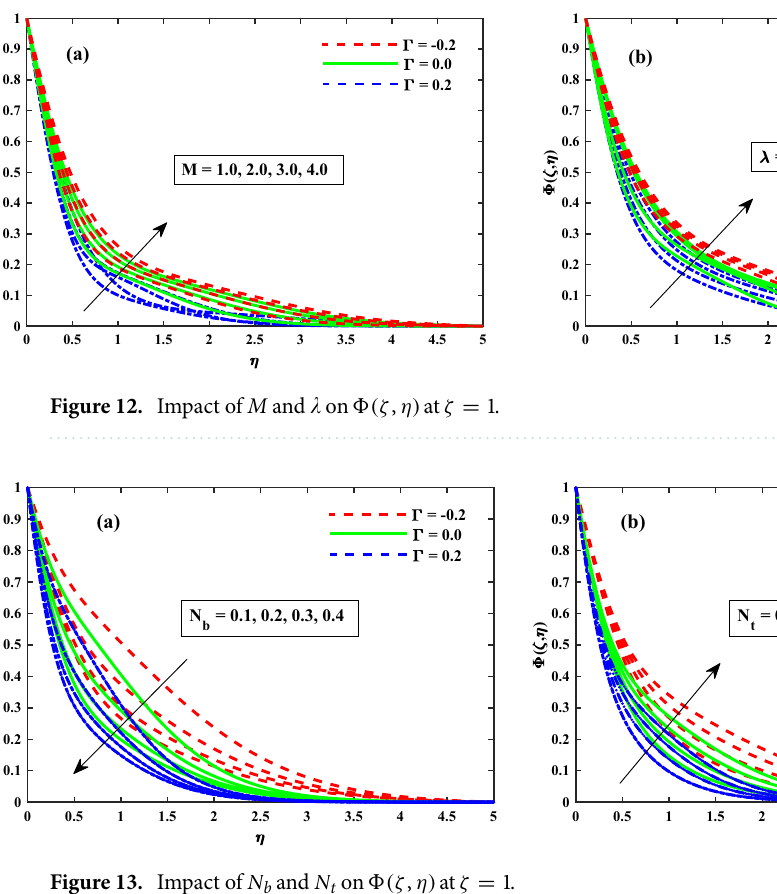
Figure 13. Impact of N b and N t on �(ζ , η) at ζ